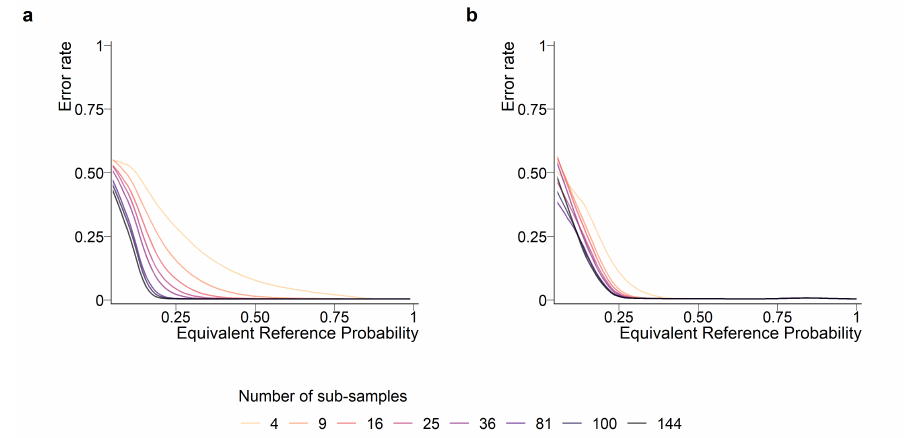
Figure 5. Error rates in reference labels as a function of landscape fragmentation for majority point-based ( a ) and partition-based ( b ) designs. Low equivalent reference probabilities are caused by large